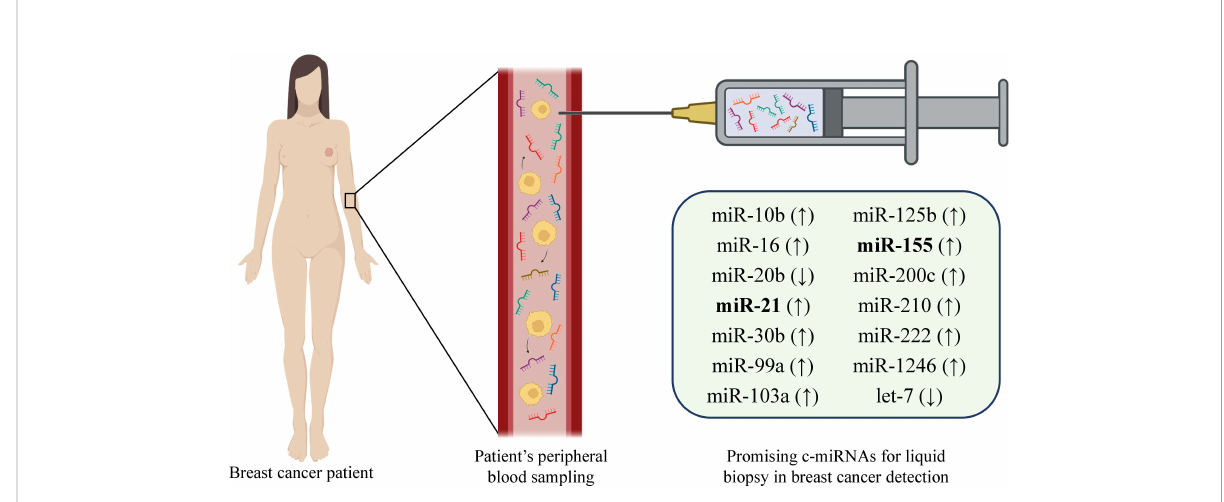
FIGURE 3 Representative miRNA candidates with the potential of biomarker function in breast cancer diagnosis and